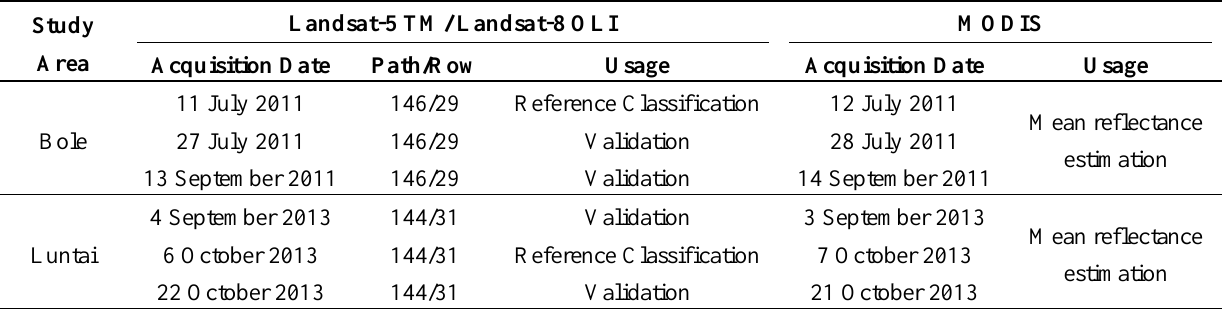
Table 1. Satellite images used in this